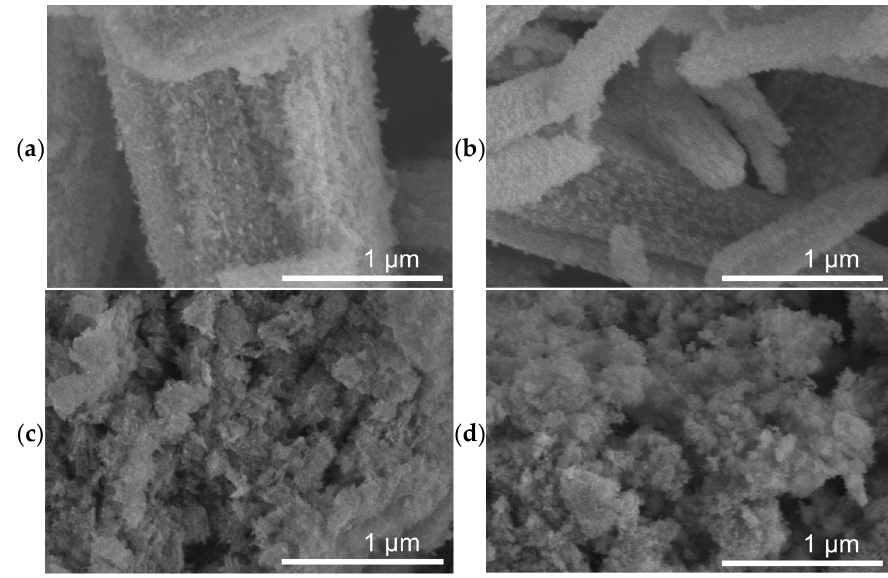
Figure 1. SEM images of fresh ( a ) FeO x , ( b ) 1%-Cu/FeO x , and ( c ) 3%-Cu/FeO x , ( d ) 5%-Cu/FeO x . For additional images, see Figure S9. Table 1. Fractions of various forms of iron oxide components in the fresh catalysts, obtained from SEM images with EDX analysis of the highlighted part are depicted in Figure XRD data using Rietveld refinement of analysis and specific surface area of fresh catalysts, as deter- mined from adsorption/desorption of nitrogen on the surface of the fresh catalysts. Multipoint BET was assessed using Roquerol’s method.